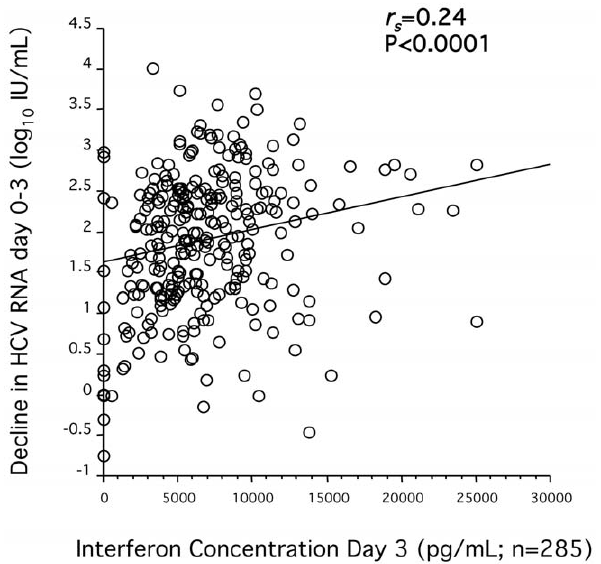
Figure 4. Impact of interferon concentration on first phase decline in HCV RNA. Correlation between the plasma concentration of peginterferon (pg/mL) treatment day 3 and decline in HCV RNA (log 10 IU/mL) between baseline and treatment day 3 of combination therapy evaluated by use of Spearman’s rank correlation coefficient r s test.